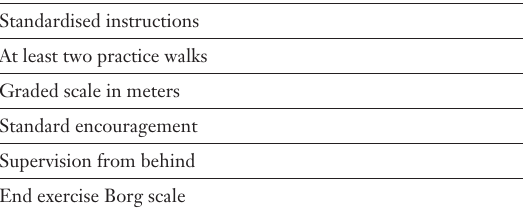
Table 3 Indications for a 6-minute walk test (adapted from refer- ence